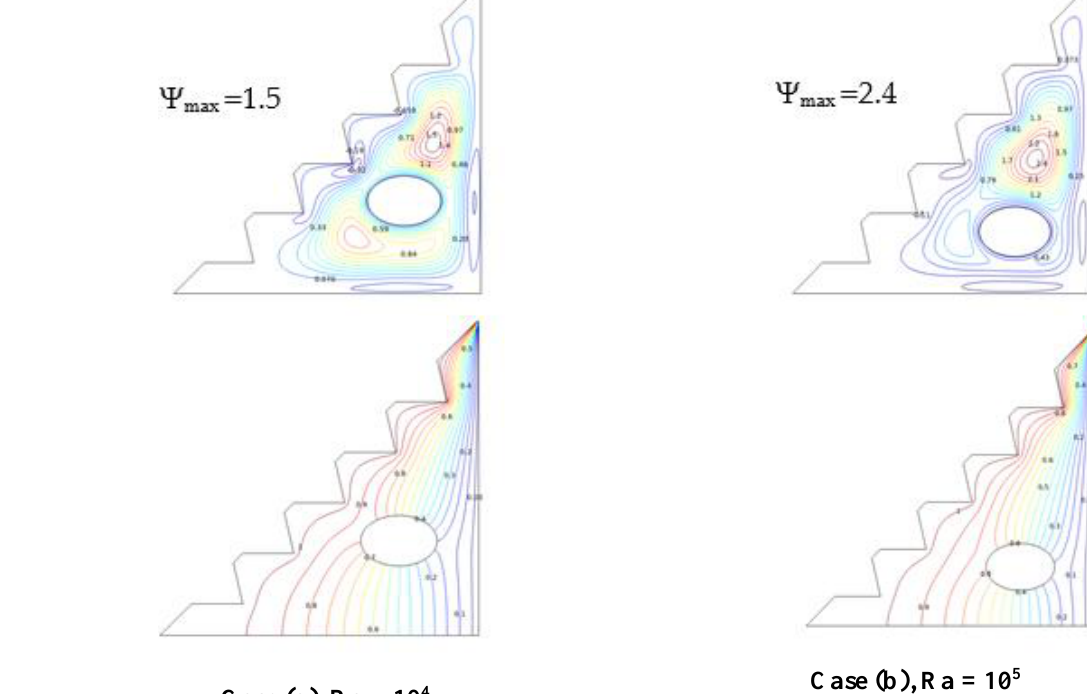
Figure 8. Streamlines and isotherms for Ha = 0, w = 0, and φ = 0.02.